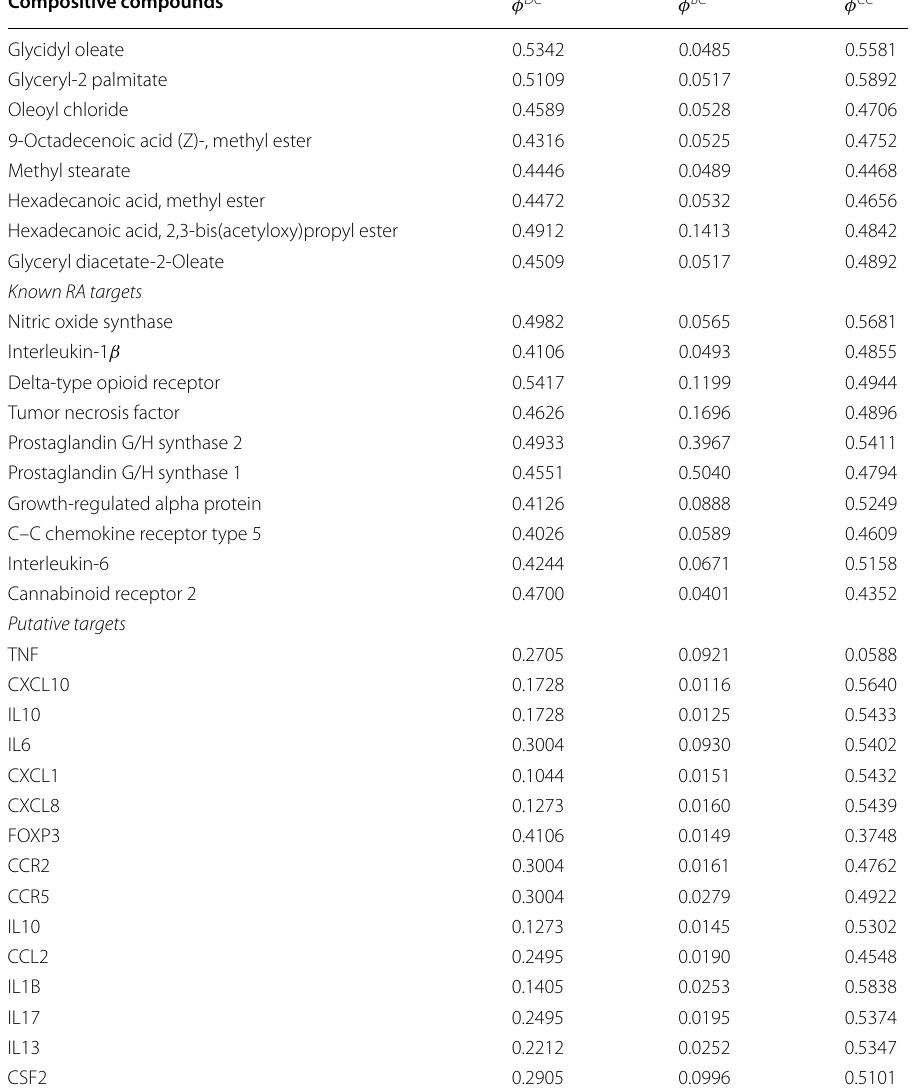
Table 1 Weighted centrality scores of major targets acting on rheumatoid arthritis Compositive compounds